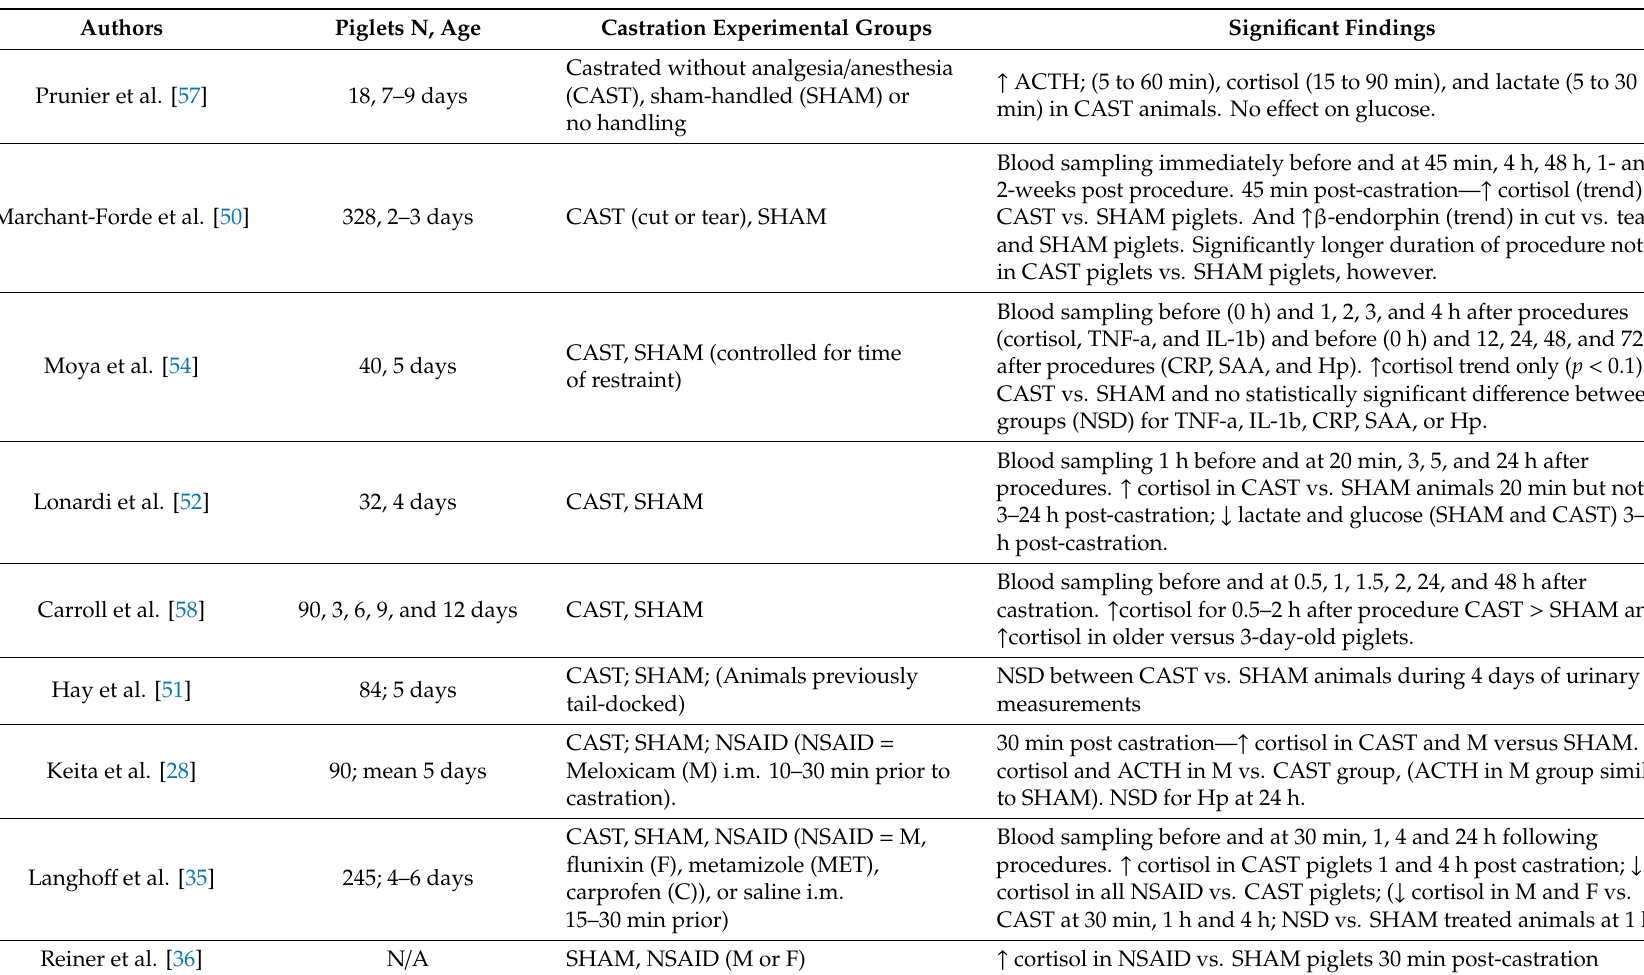
Table 1. Summary of studies investigating physiological (neuro-endocrine and inflammatory) responses during piglet